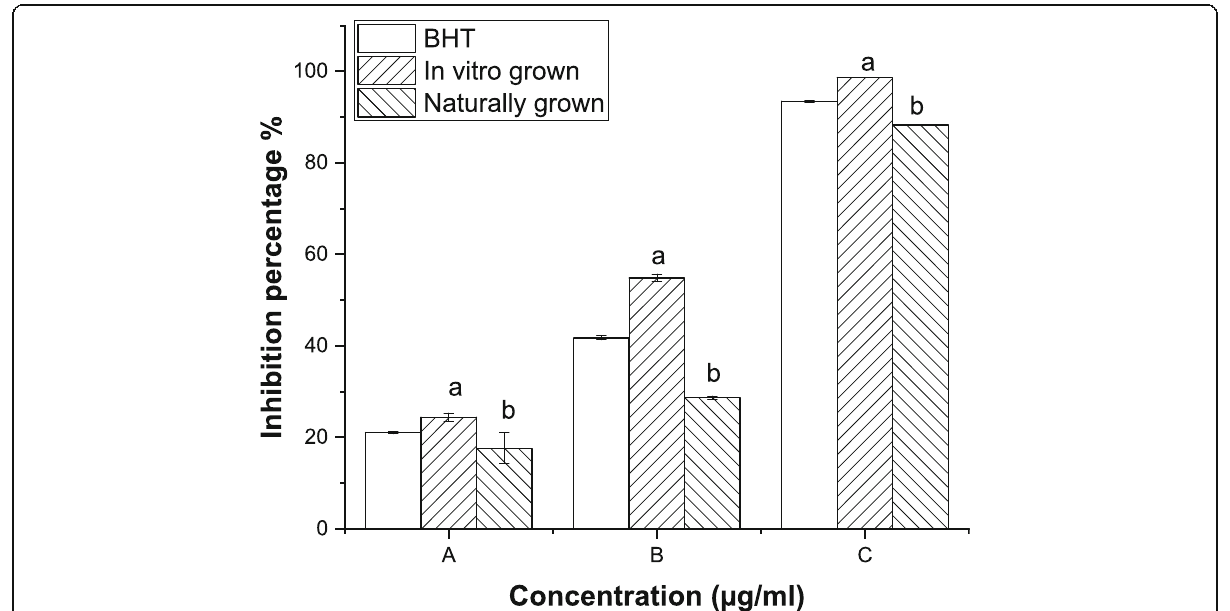
Fig. 3 ABTS + scavenging activity of in vitro and naturally grown L. cruciata and their comparison with standard BHT . Values with different letters (a, b) are significantly ( p < 0.05) different from each other by Turkey ’ s multiple range test